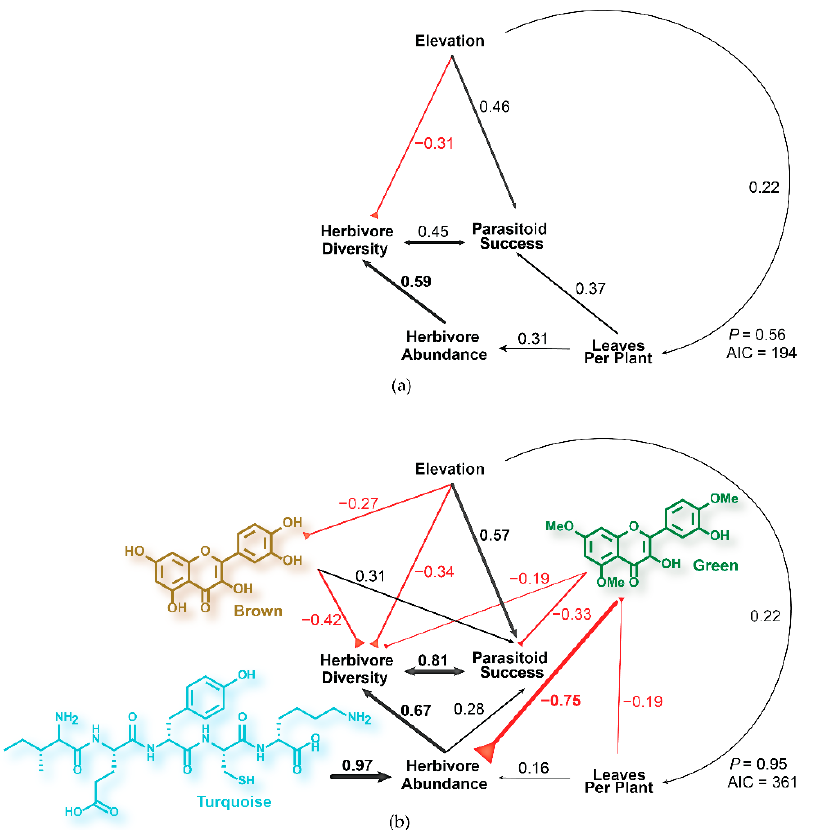
Figure 3. ( a ) Structural equation model predicting the effect of elevation on parasitoid success, herbivore diversity, and abundance mediated by C. velutinus leaves per plant within plots. ( b ) Structural equation model predicting herbivore diversity and abundance based on plant properties, abiotic factors, and chemical modules. The SEM incorporating chemical variables explains 33% more variance than the model without chemistry. Brown and green modules represent flavonoids, known defensive compounds, while the turquoise module represents peptides, a possible indicator of nutritional quality and nitrogen content.